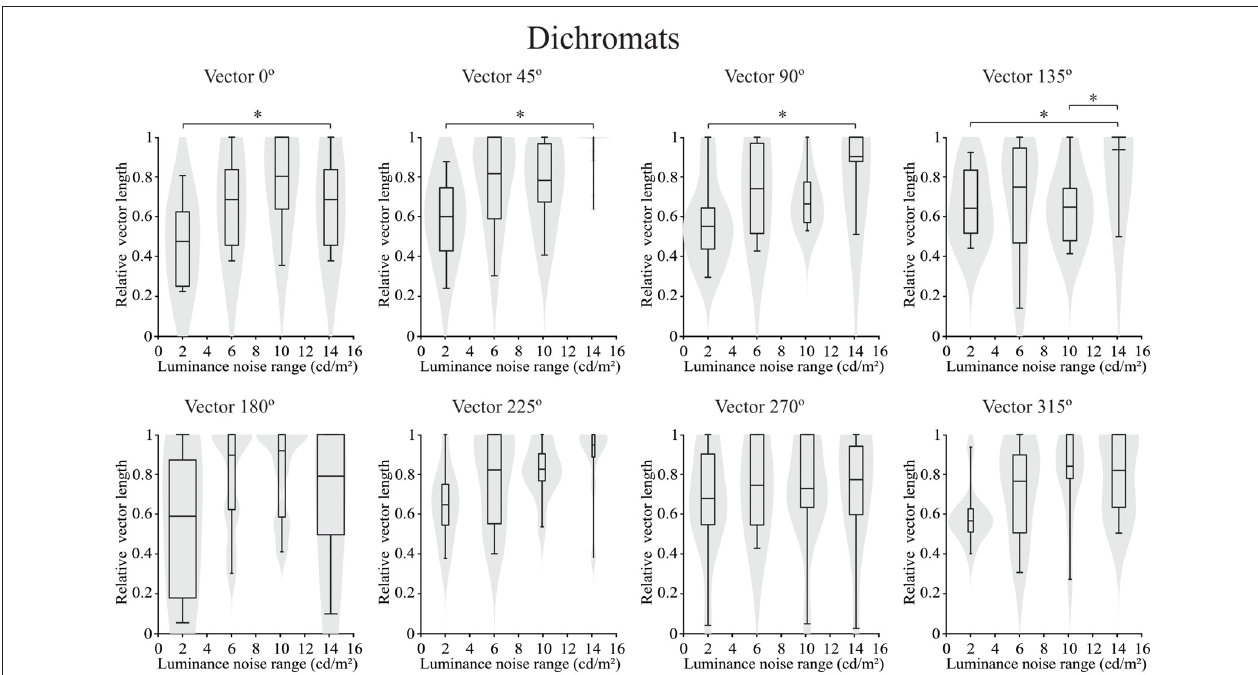
FIGURE 6 | Violin plots of chromatic thresholds estimated from congenital dichromats as a function of the luminance noise amplitude at each chromatic vector. There was difference between luminance noise amplitude conditions of 14 cd/m 2 and 2 cd/m 2 at the chromatic axes 0 ◦ , 45 ◦ , 90 ◦ and 135 ◦ from dichromats data. Here again the low luminance noise amplitude improved the color discrimination compared to high luminance noise amplitude. Shaded gray areas are the kernel density plot that represents 95% of the data distribution, and the box plot comprises horizontal lines that represent third quartile (upper line), median (middle line), first quartile (lower line) and whiskers represents the maximum and minimum values. ∗ p < 0.05.